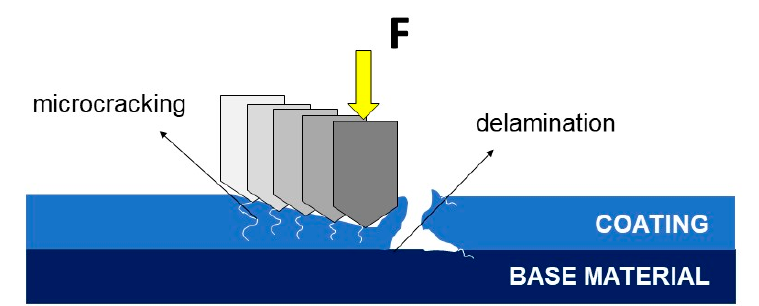
Figure 7. Coating adhesion failure during scratch test.